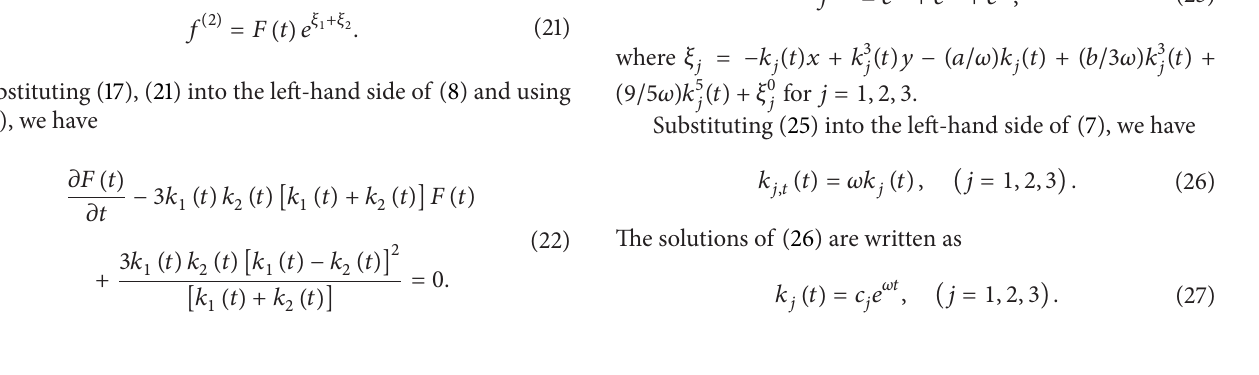
Figure 2: The shape and motion of the one-soliton solution for 𝜔 = −0.8 , 𝑎 = 1 , 𝑏 = 1 , 𝑐